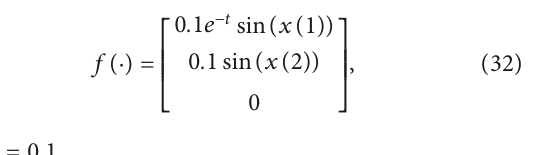
Figure 5: Synchronization errors of the lifting system. Table 3: Effect of load size on synchronization accuracy errors. Load (N)